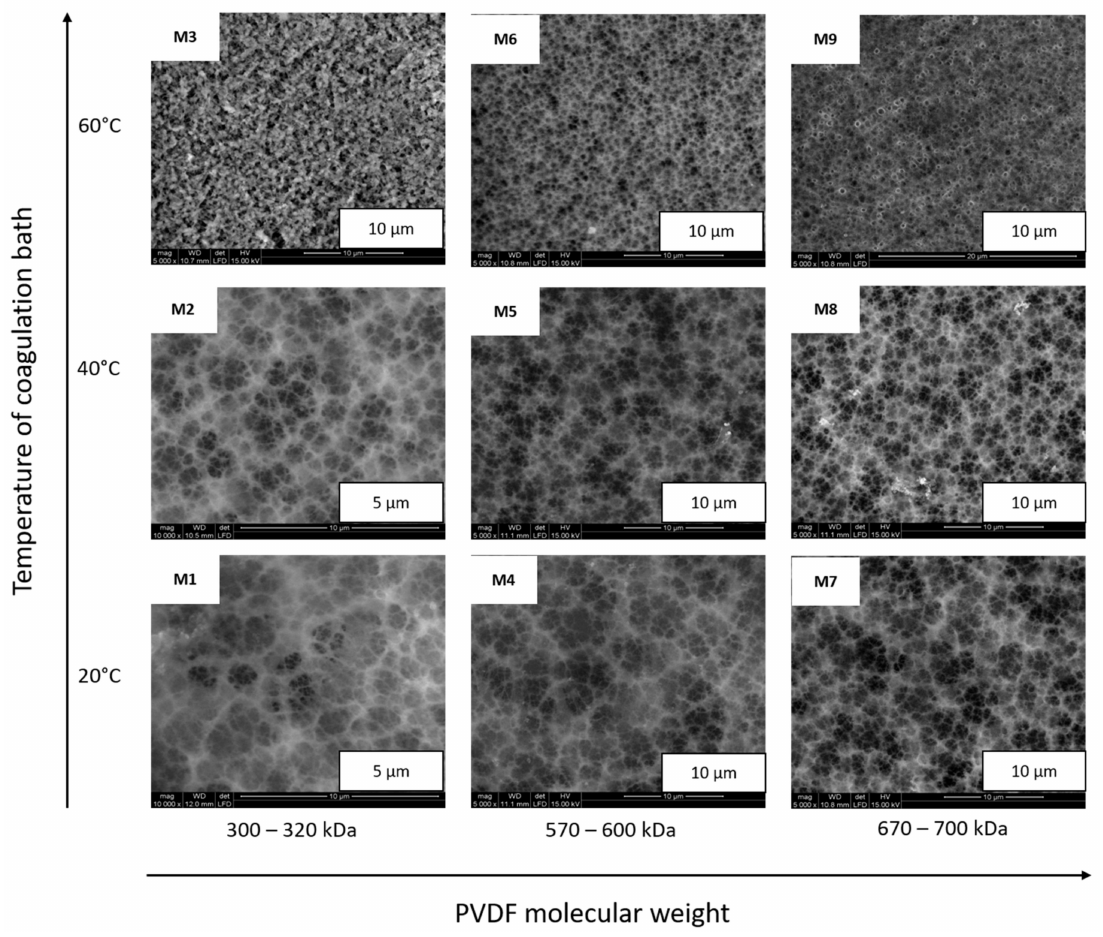
Figure 4. Environmental scanning electron microscope (ESEM) micrographs of the M1–M9 membrane top